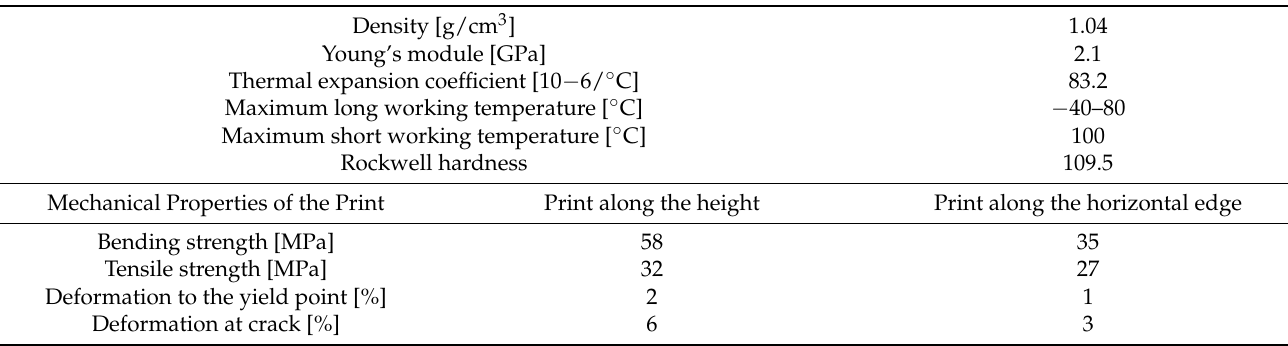
Table 4. Material characteristics of the ABS P430